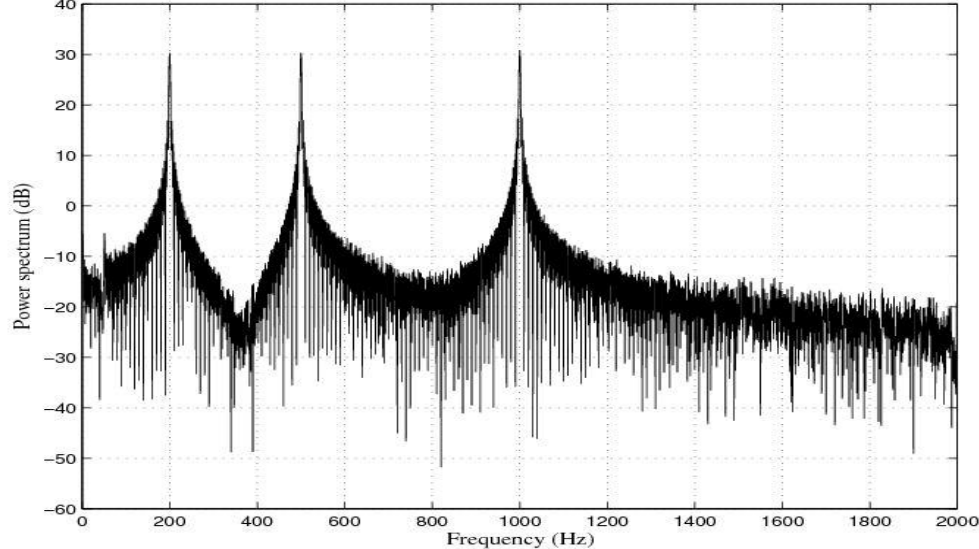
Figure 6. Response of the sensor system before filtering for a multi-frequency acceleration of maximum amplitude 2 g and frequencies 200 Hz, 500 Hz and 1 kHz: Power spectrum